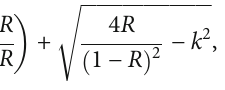
Figure 8: Variation of the extinction coe ffi cient ( k ) of all Al-Ni- codoped SnO thin fi 2